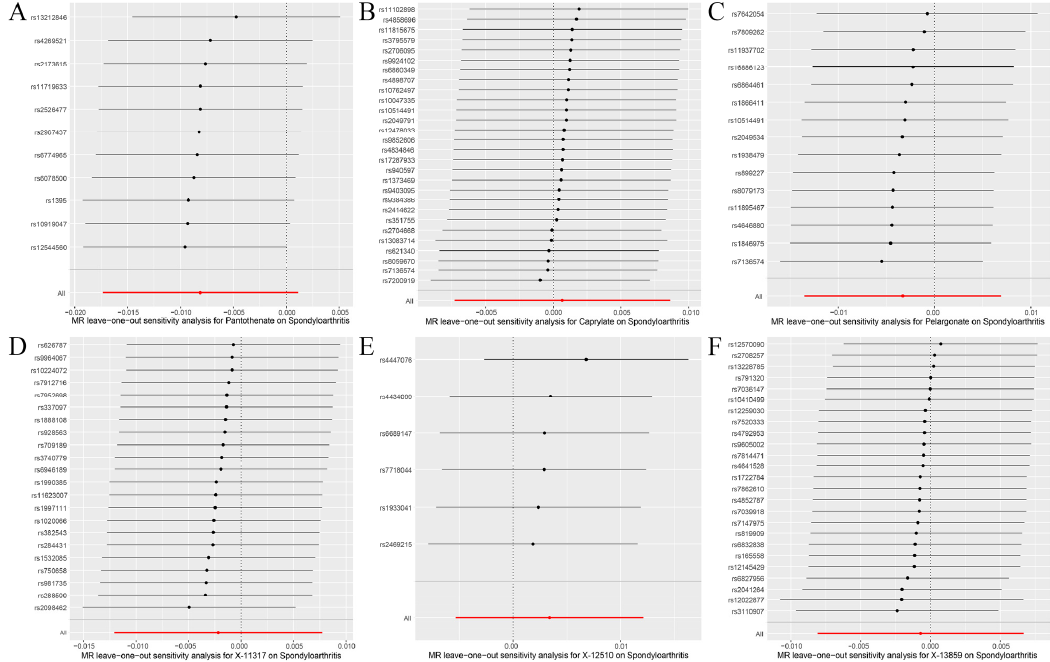
Figure 4. Scatter plot of MR analysis results between blood metabolites (pantothenate, caprylate, pelargonate, X-11317, X-12510, and X-13859) and spondyloarthritis. ( A ) Pantothenate and spondy- loarthritis; ( B ) caprylate and spondyloarthritis; ( C ) pelargonate and spondyloarthritis; ( D ) X-11317 and spondyloarthritis; ( E ) X-12510 and spondyloarthritis; ( F ) X-13859 and spondyloarthritis. relationship with SpA (Supplementary Figure S3A,B). The Cochran’s Q statistic (MR-